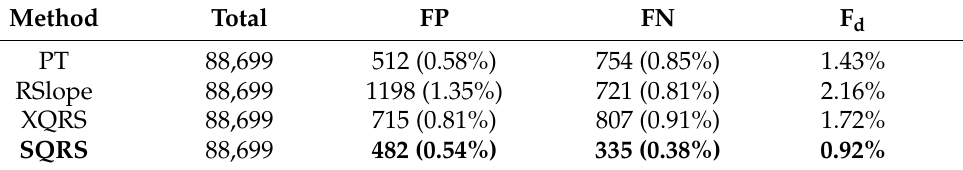
Table 3. The detection error accuracy comparison results among the four methods.